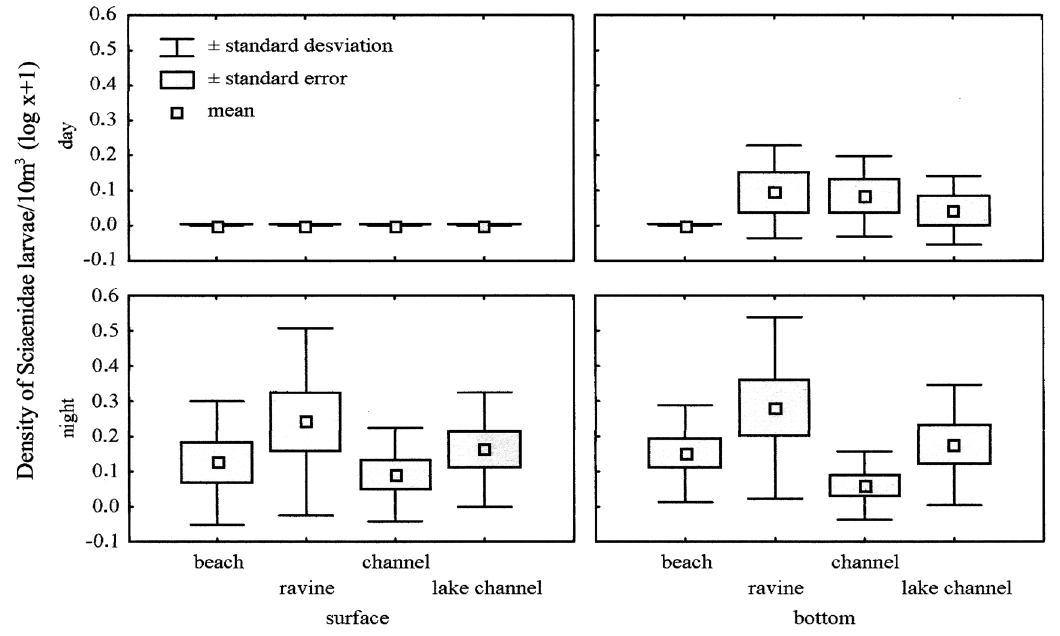
Fig. 6. Abundance of Sciaenidae larvae in different microhabitats in the surface and bottom in the Anavilhanas Ecological